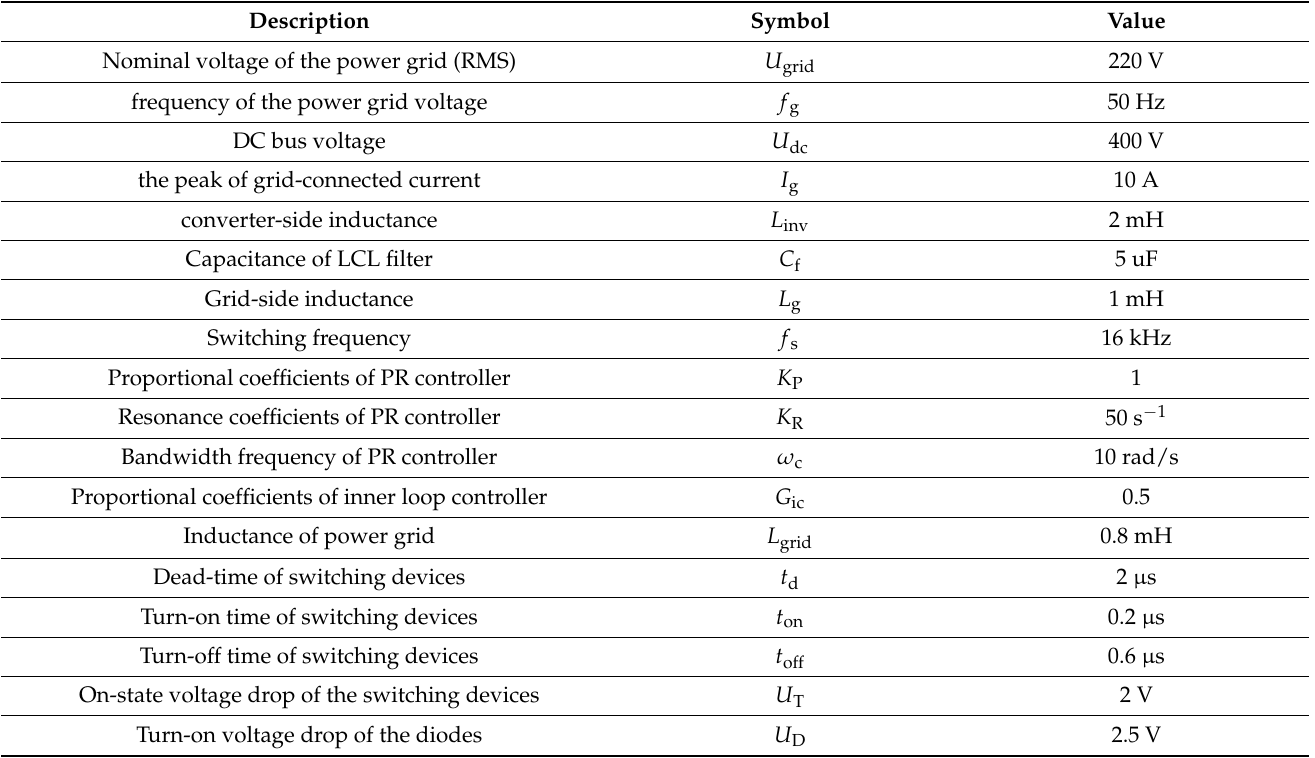
Table 1. Parameters of LCL-type grid-connected converter